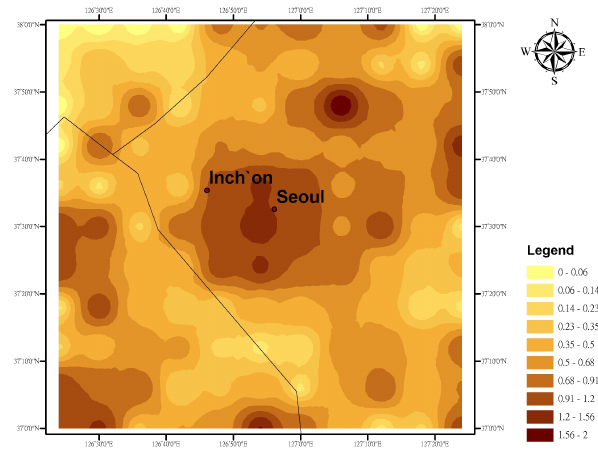
Fig. 1. Location of the sensors and the city of Seoul. Thick black and gray lines are system accuracy and detection efficiency, respec- tively. Small circles (o) indicate the location of lightning stations.